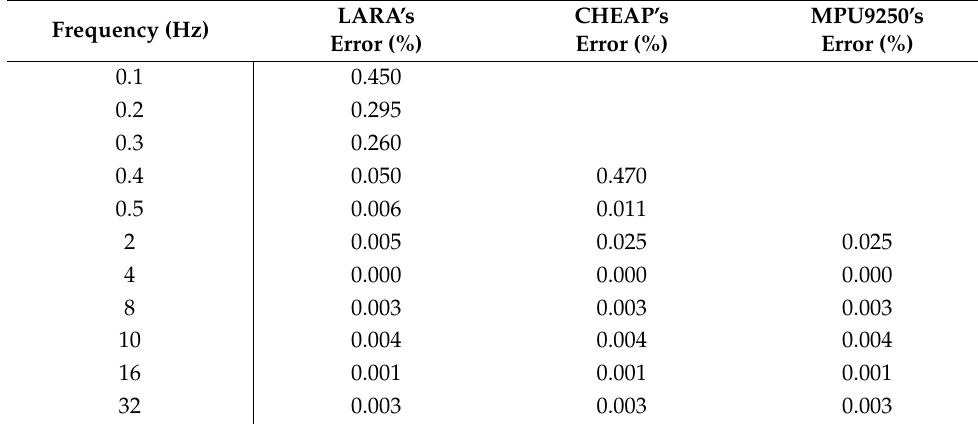
Table 3. Frequency validation of the accelerometers.